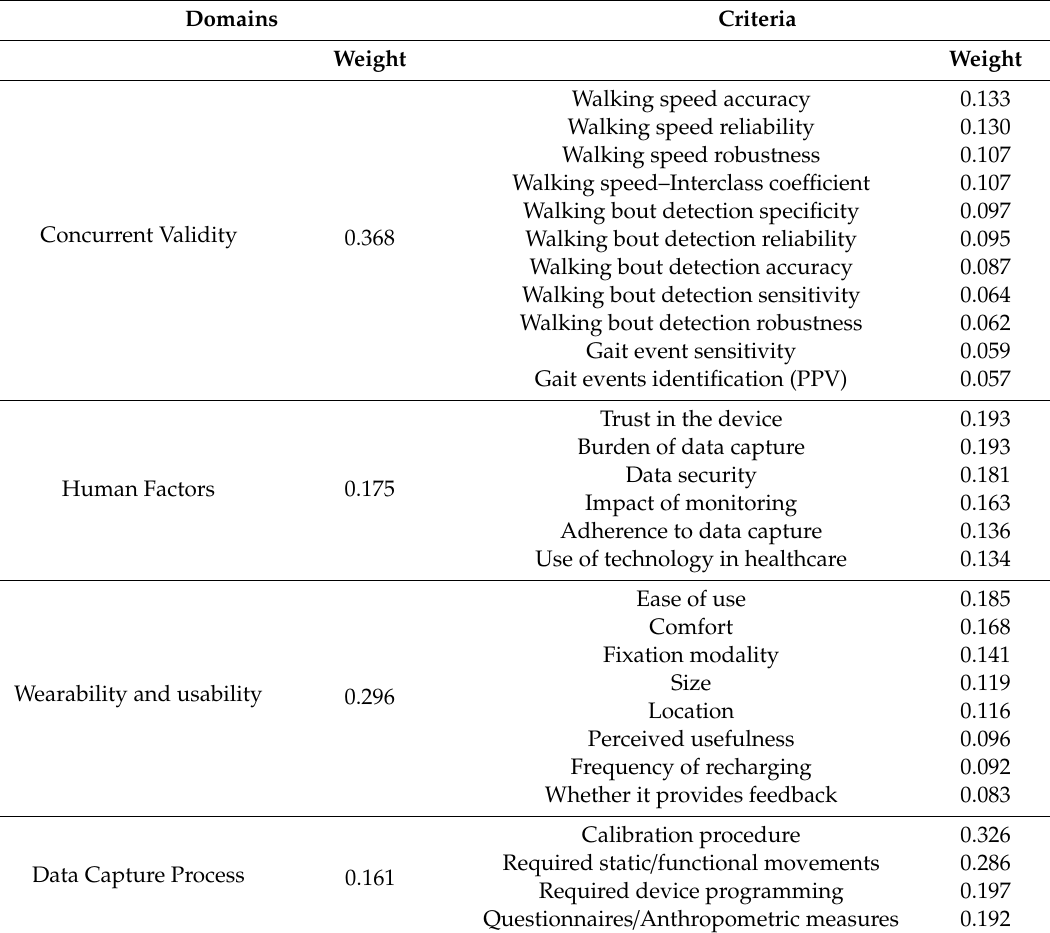
Table 2. Weighting